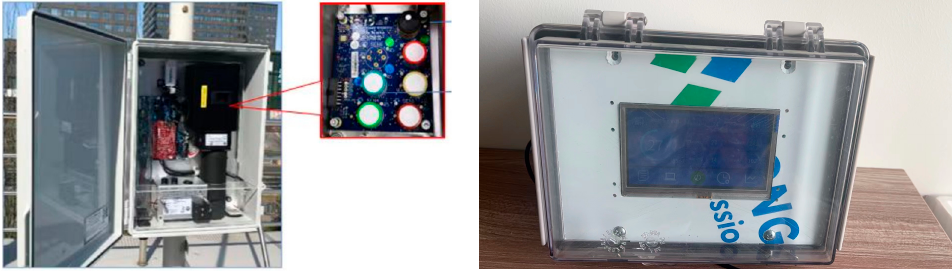
Figure 6. A self-made AQI monitoring station, used by EMULSION.